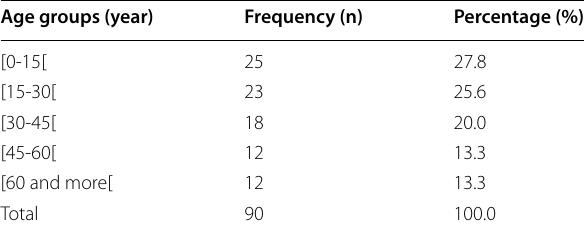
Table 1 Age groups of patients